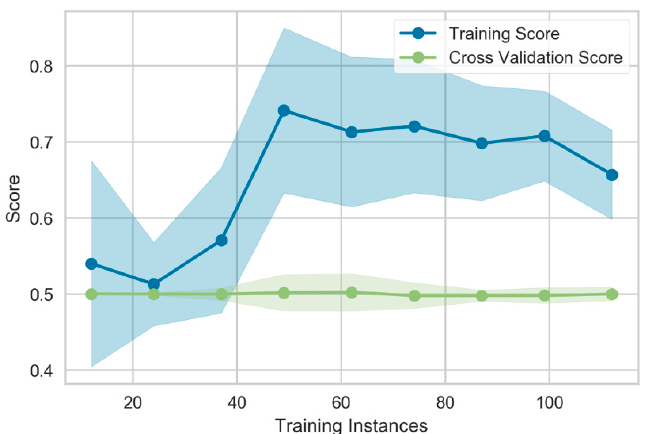
Figure 1. Learning curve for the random forest classifier for prediction of pCR after neoadjuvant chemoradiation in the rectal cancer cohort. Balanced accuracy as scoring method is depicted as a function of the used training instances. The cross-validation score remains on level with random results and does not converge, suggesting that the model would not benefit from a larger sample